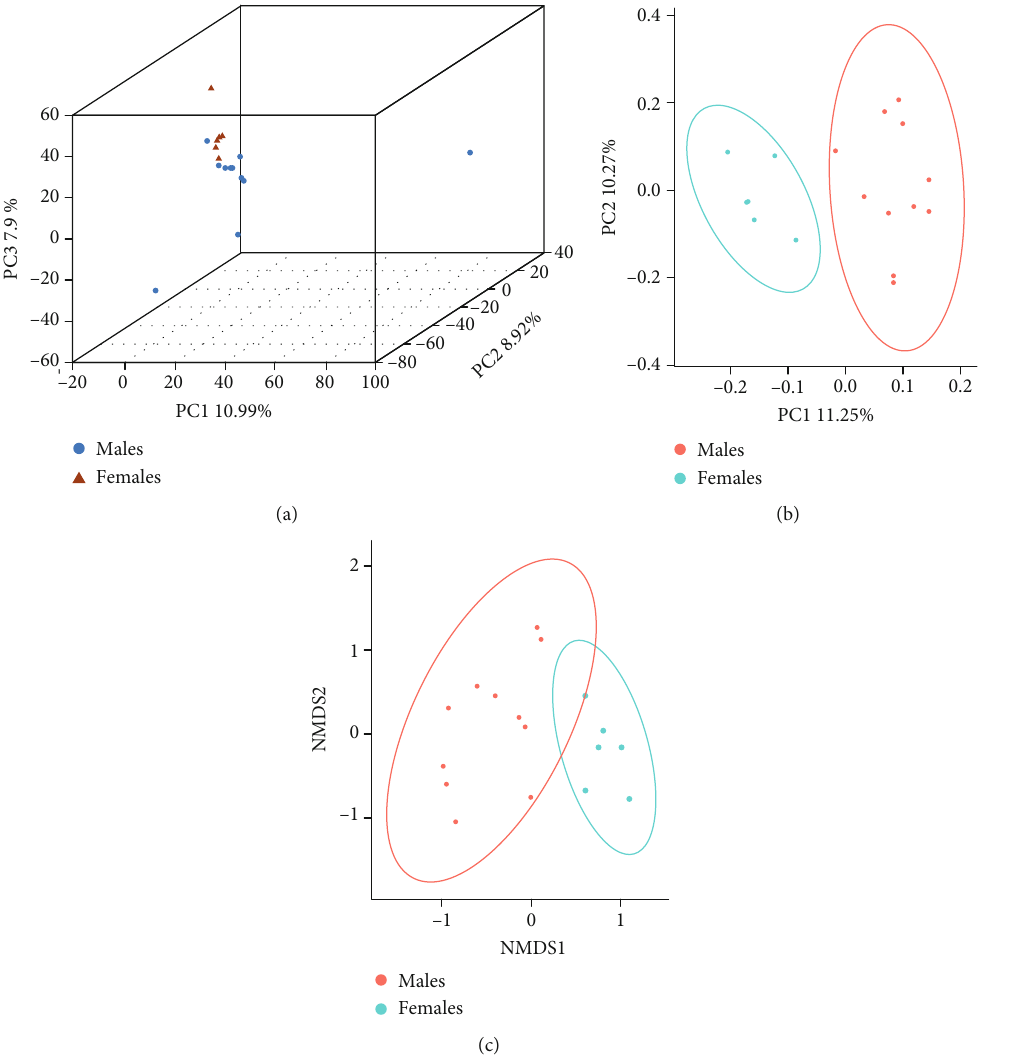
Figure 4: β -Diversity analysis of young male and female patients with severe and advanced periodontitis. (a) The similarity of the microbial communities between males and females was analyzed by principal component analysis, (b) principal coordinate analysis, and (c) nonmetric multidimensional scale (NMDS) based on the unweighted UniFrac